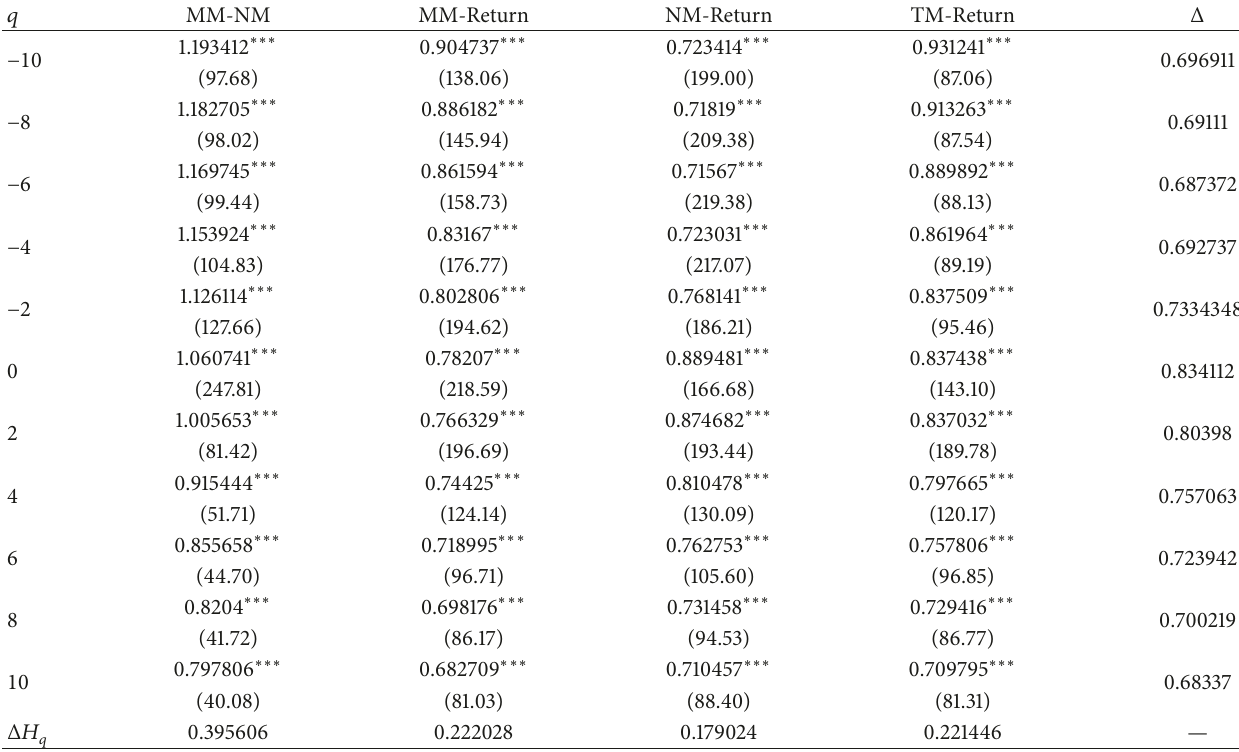
Table 1: Results of the MF-DCCA scaling exponent. This table reports the MF-DCCA scaling exponent between the amount of mass media news, the amount of new media news, the amount of total news, and the return of SSE 50. The symbol “MM-NM” denotes the scaling exponent between mass media news amount and new media news amount. The symbol “MM-Return” denotes the scaling exponent between mass media news amount and the return of SSE 50. The symbol “NM-Return” denotes the scaling exponent between new media news amount and the return of SSE 50. The symbol “TM-Return” denotes the scaling exponent between the total news amount and the return of SSE 50. The symbol “ Δ ” denotes the difference between TM-Return and the sum of MM-Return and NM-return.